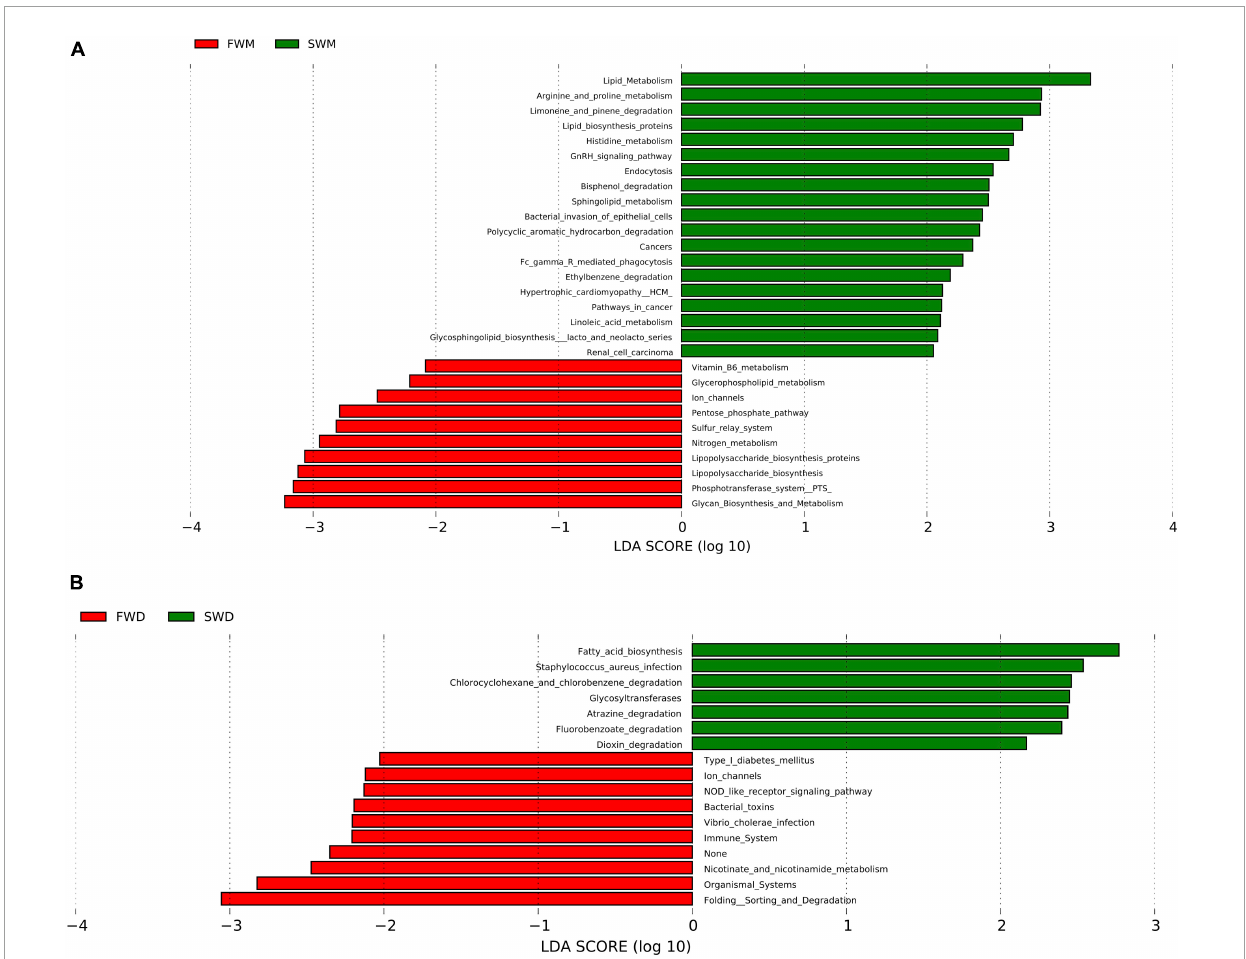
FIGURE5 Comparisons of predictive KEGG pathways between (A) mucosa-associated and (B) digesta-associated microbiota of FW and SW individuals. FWM, freshwater mucosa samples; SWM, seawater mucosa samples; FWD, freshwater digesta samples; SWD, seawater digesta